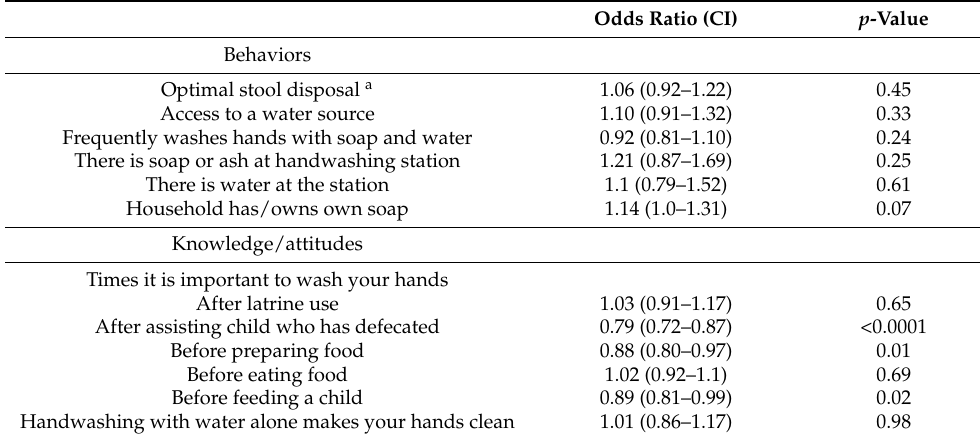
Table 4. Regression analysis for parental WASH behavior and knowledge with care-seeking behaviors for diarrhea (N = 9993).